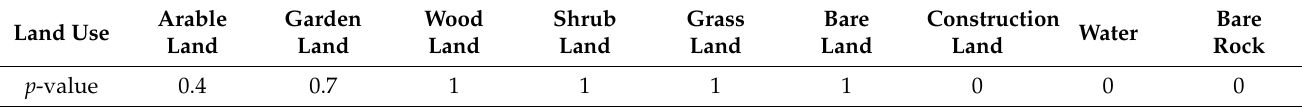
Table 2. Land use types and p